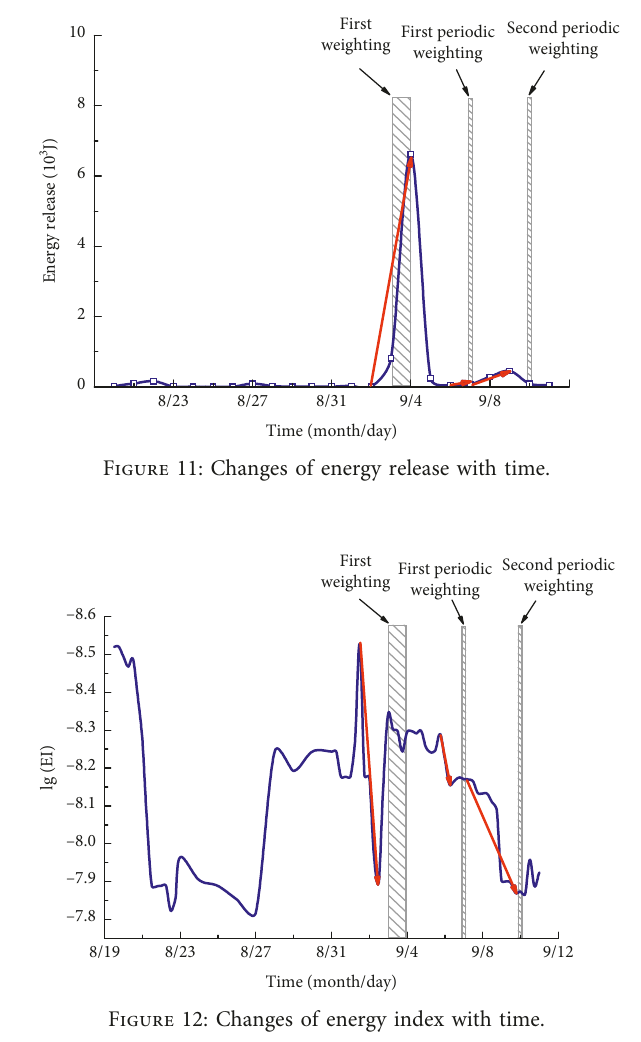
Figure 13: Changes of Schmidt number with time.